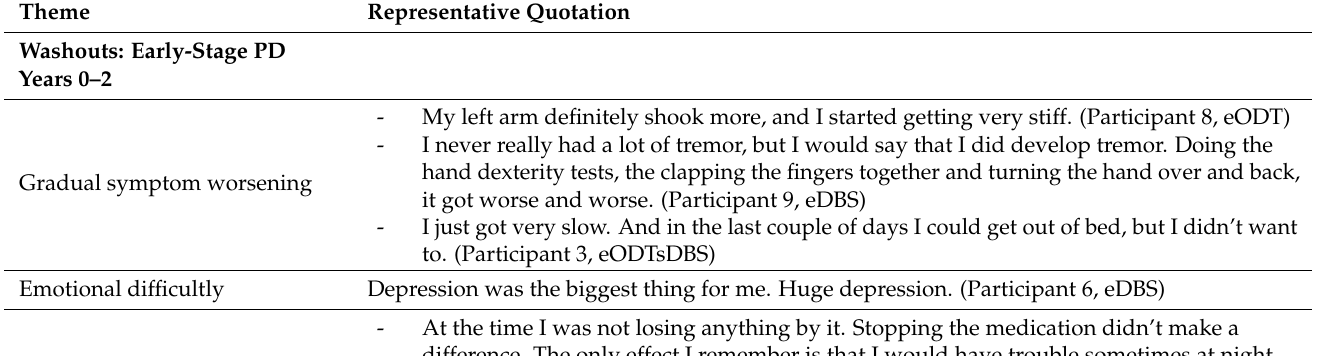
Table 2. Thematic factors and representative quotations significant in the washout